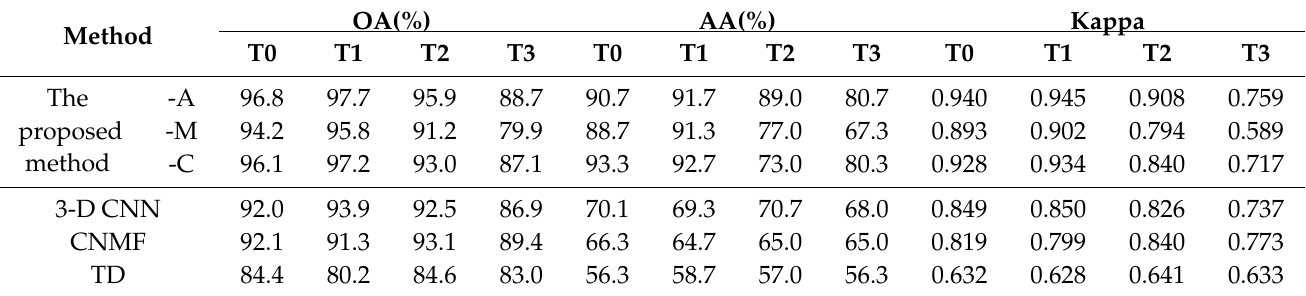
Table 4. Identification performance table of the simulated data